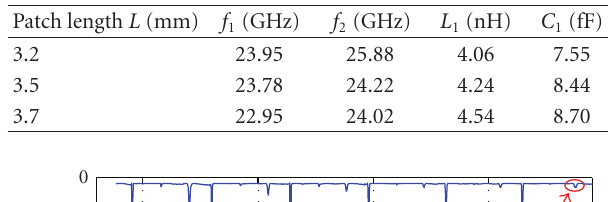
Table 2: Resonant frequencies f 1,2 and relative values of parameters L 1 , C 1 .